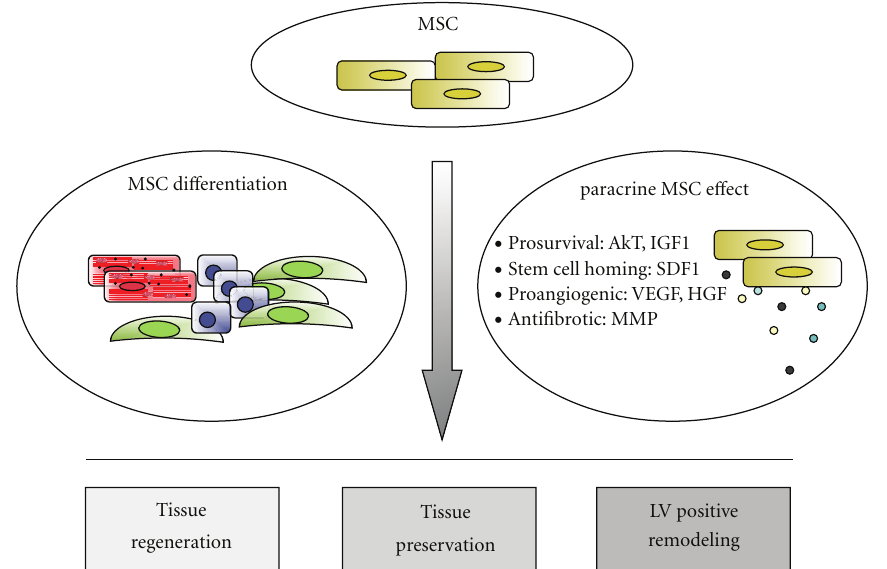
Figure 1: Main MSC actions on injured myocardium. Mesenchymal progenitors transplanted onto the ischemic myocardium are able to secrete a plethora of therapeutic molecules (paracrine activity) and even to di ff erentiate towards (cardio-) vascular lineages, encouraging the healing of the damaged tissue, avoiding its transition to a scarred muscle, and regenerating the heart tissue mainly at the vascular level. Abbreviations: IGF-1: insulin-like growth factor-1; SDF-1: stromal derived factor-1; VEGF: vascular endothelial growth factor;